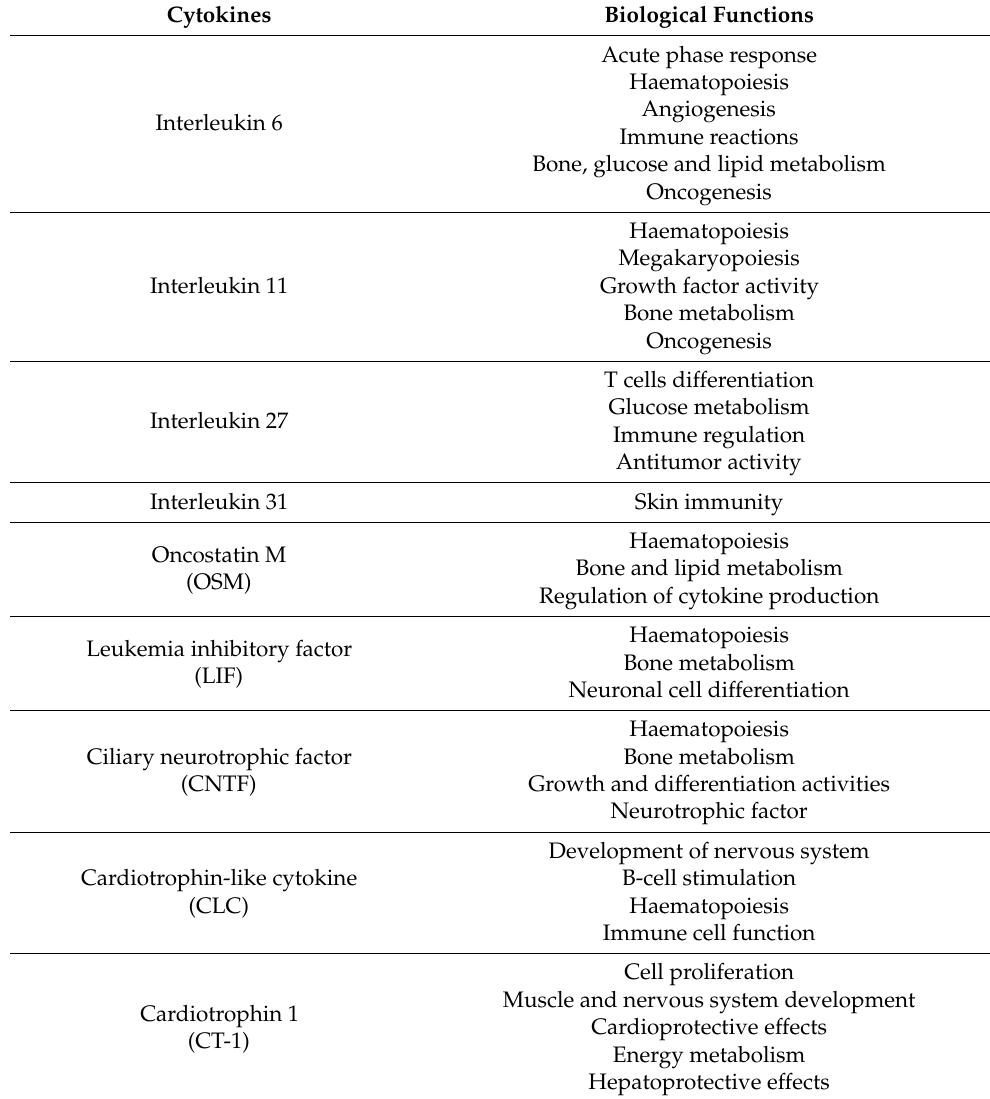
Table 1. Main biological functions of IL-6 family